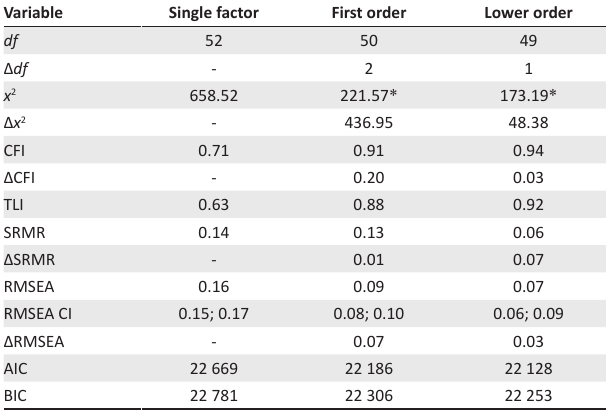
TABLE 3: Fit statistics for a first-order, single-factor and lower-order model of Passion.